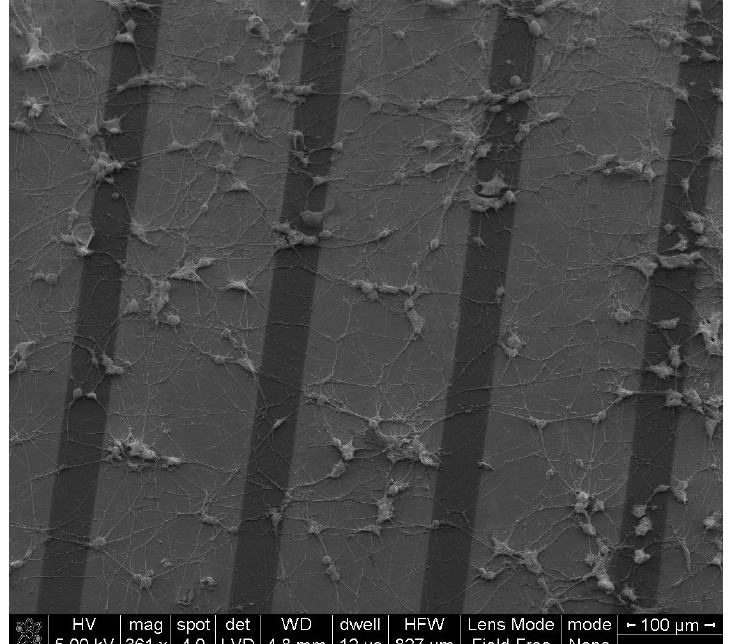
Figure 8. SEM image of PC12 cells cultured on the Au/PPy electrode